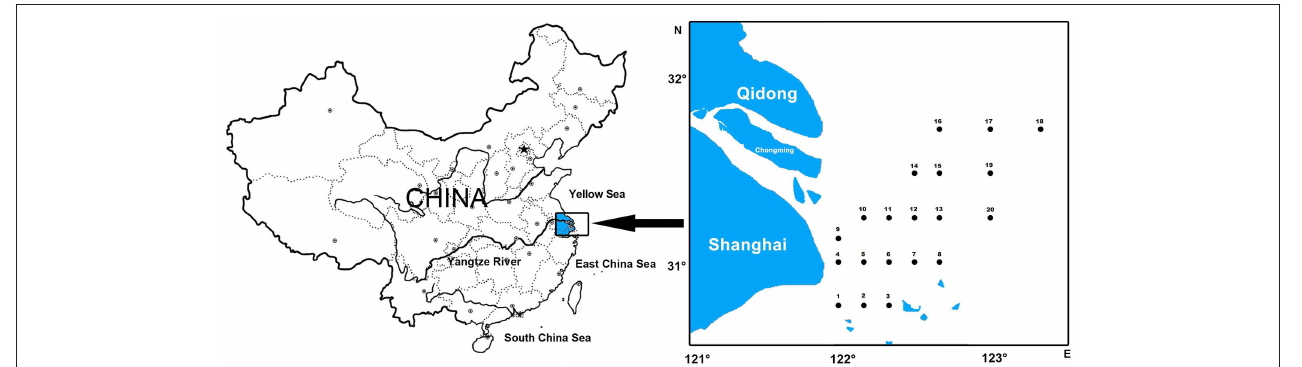
FIGURE 1 | Sampling